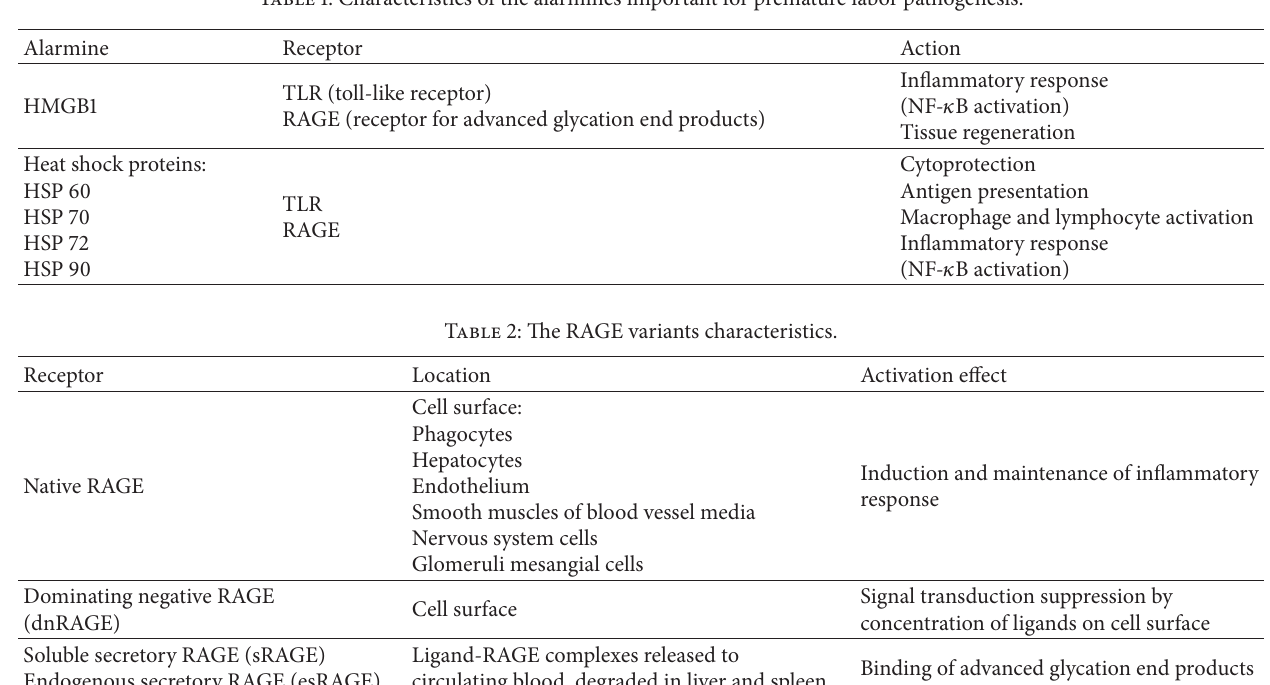
Table 1: Characteristics of the alarmines important for premature labor pathogenesis.